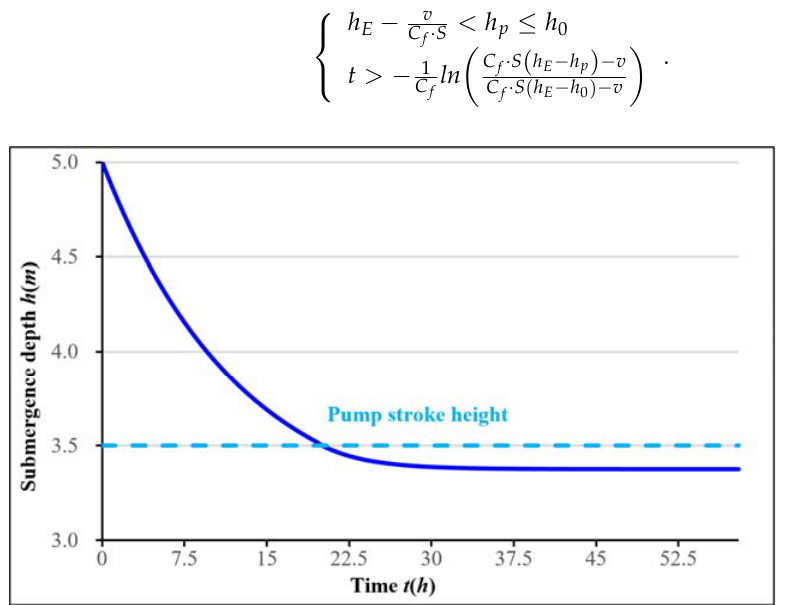
Figure 4. Schematic diagram of transition from the full ‐ pumping state to the nonfull ‐ pumping state. The denominator of Formula (11) is C f · S ( h E − h 0 ) − v (cid:54) = 0; otherwise, the submer- gence depth of the full-pumping state model in Formula (5) will have a constant value of h 0 , and the pumping state will not change.